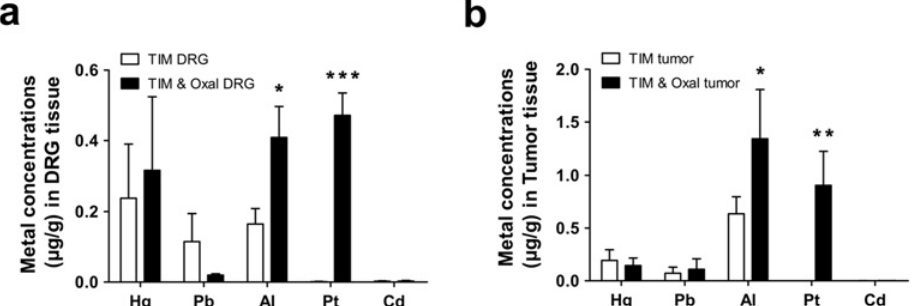
Fig 5. Al accumulation in DRG and tumor tissue of oxaliplatin-treated mice with induced tumors. Tumors were induced in mice by injection of murine CT26 colon cancer cells. 5% dextrose (Tumor Induced Model: TIM) and oxaliplatin (TIM & Oxal; 3 mg/kg) were administered by i.p. injection on days 14 through 18 after transplantation. The extracted DRG and tumor tissues were analyzed by inductively coupled plasma mass spectrometry (ICP-MS). Figures show the increases in Al and Pt concentrations in DRG (a) and tumor (b) tissues from oxaliplatin-treated mice. Results are representative of two independent experiments. Values are expressed as the mean ± SEM ( n = 10 per group). * p < 0.05, ** p < 0.01, and *** p < 0.001 compared with the control group.